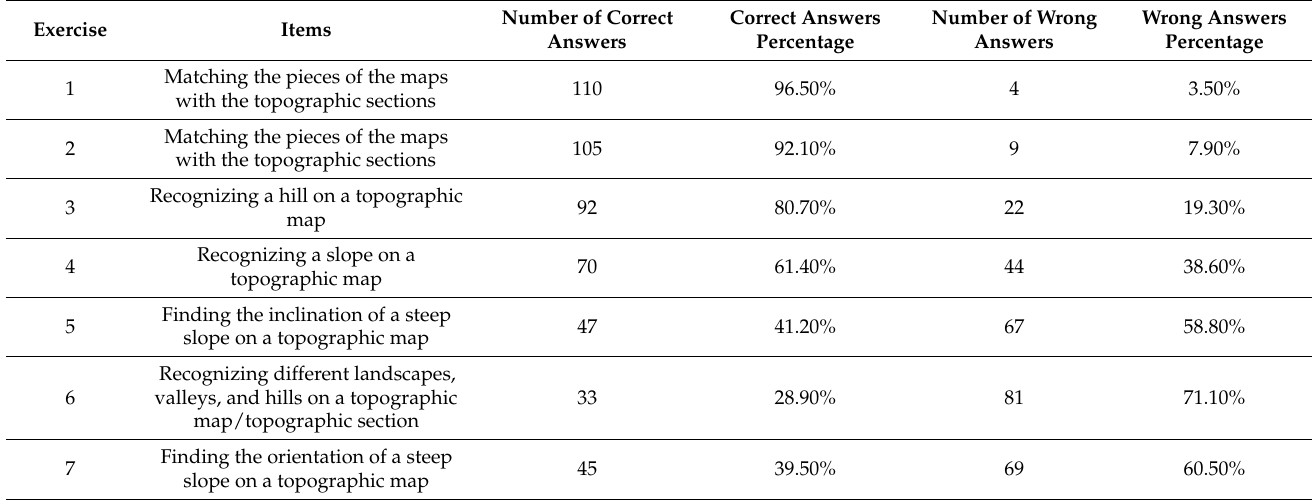
Table 5. Summary of students’ answers on the maps